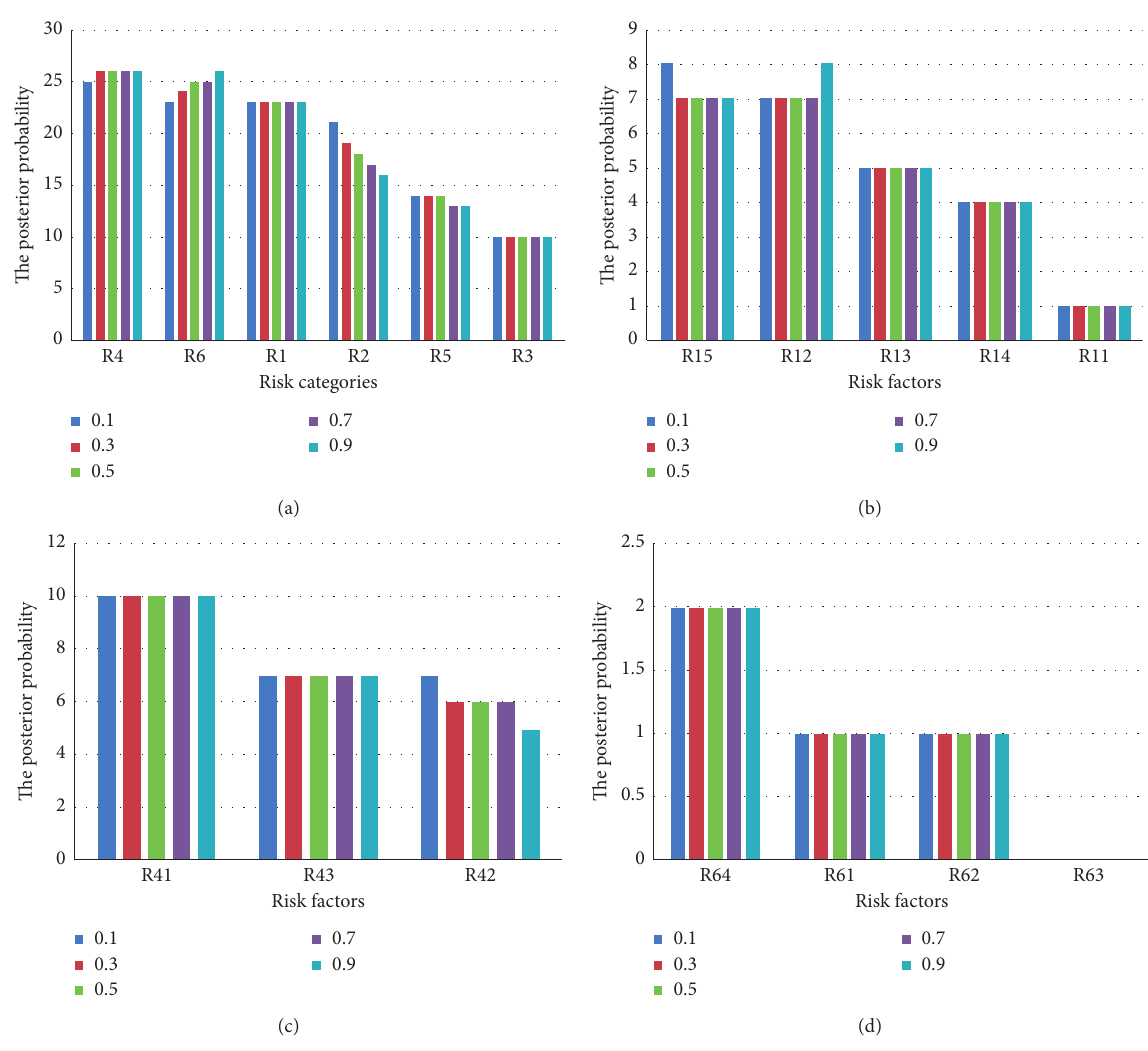
Figure 9: Sensitivity analysis according to the β